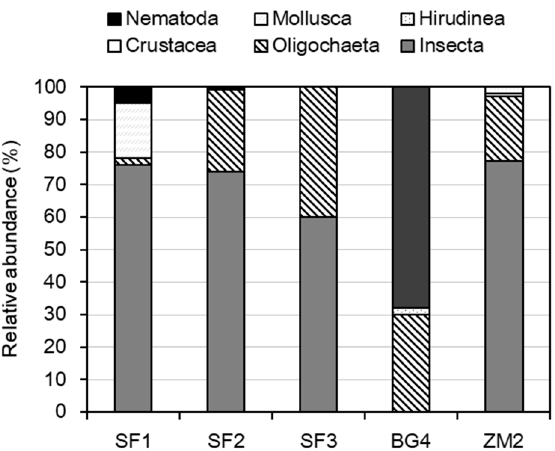
Figure 2. Relative abundance of different taxonomic groups (Hirudinea, Crustacea, Insecta, Oligochaeta, Mollusca, and Nematoda) identified in sediments from each sampling station at the São Francisco River (SF1, SF2, SF3, BG4, and ZM2).